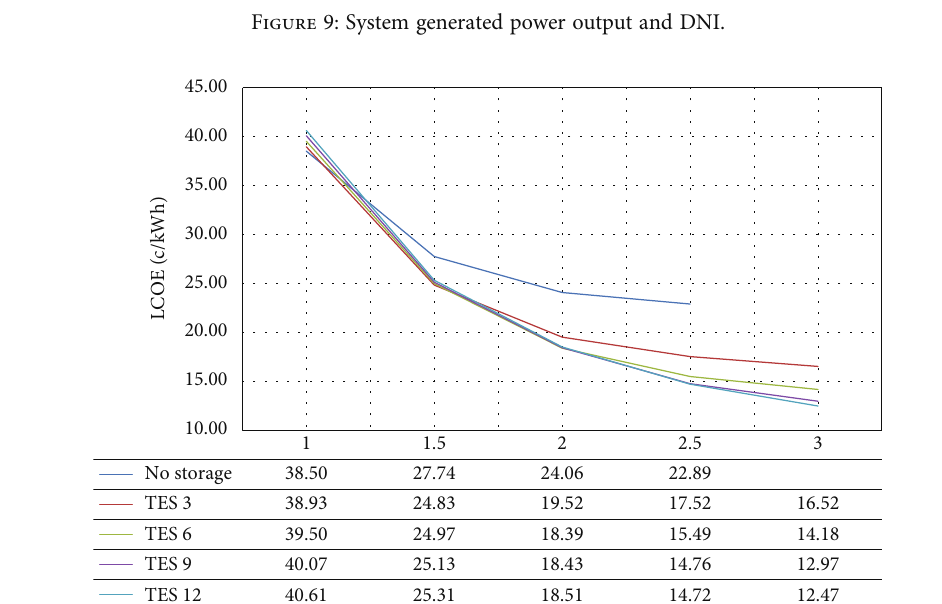
Figure 9: System generated power output and DNI.